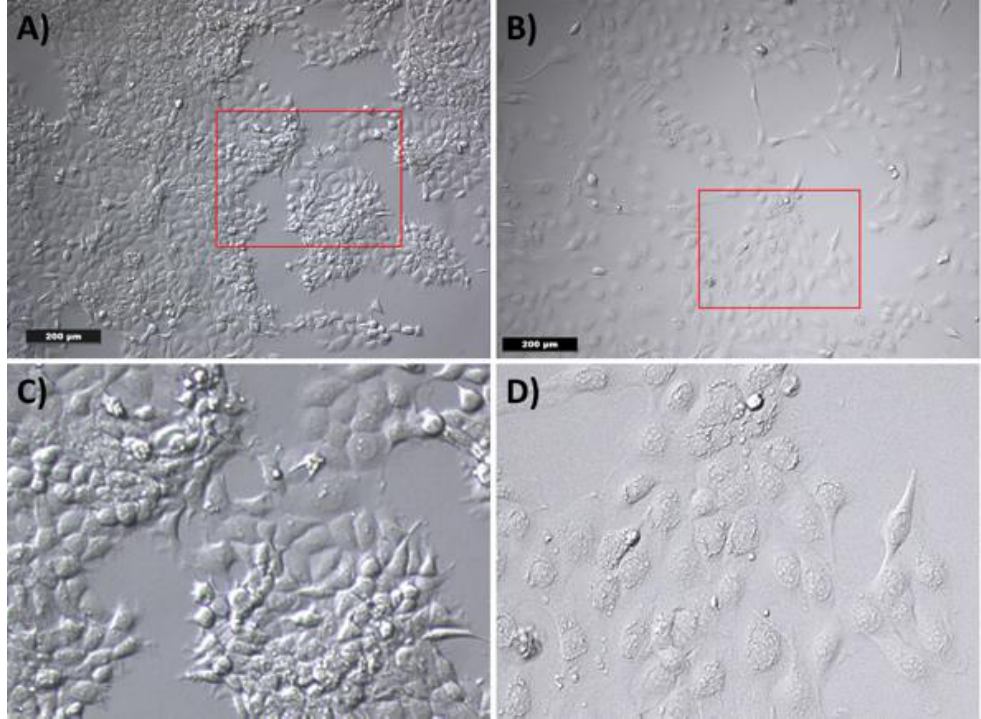
Figure 5. Cell morphology of tumor cells by incubation with ( A ) RPMI-EM and ( B ) WF. ( C ) and ( D ) show a digital magnification of the red marked area of ( A ) and ( B ), respectively. After incubation with ( A ) RPMI-EM, the tumor cells show a polygonal epithelial appearance. An elongated fibroblast-like cell morphology was observed after incubation with WF.